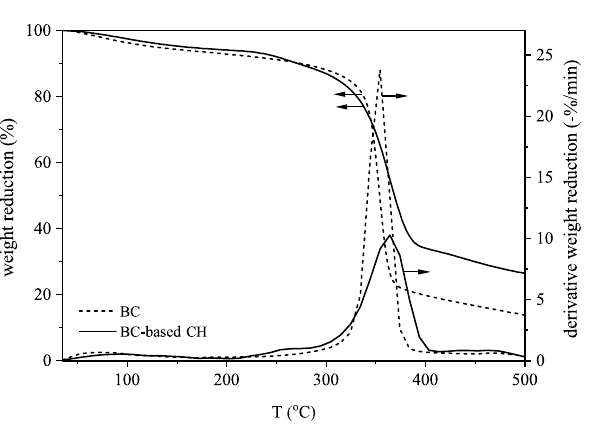
Figure 4. Polymers were adjustable to change structurally using glycerol (CH 2 OH–CHOH–CH 2 OH). Hydrogen bonding formation (inter/intra-linkages) is shown schematically for ( a ) bacterial cellulose, ( b ) bacterial cellulose plus glycerol, ( c ) calcium alginate plus glycerol, and ( d ) gelatin plus glycerol.